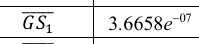
Fig. 9. Angle sum comparison (uncalibrated, calibrated, ground